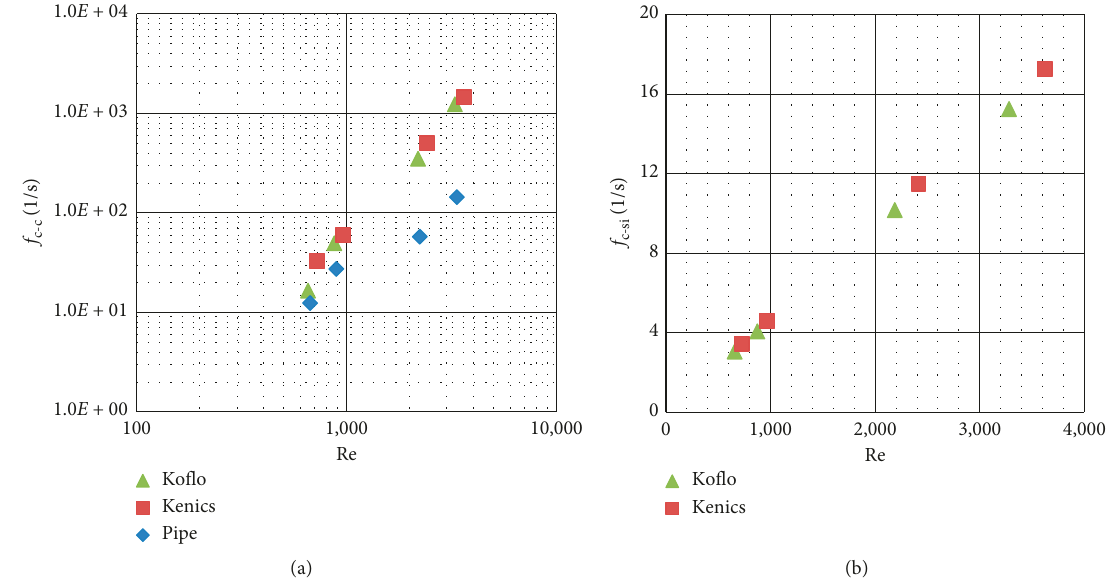
Figure 25: The frequency of interactions: (a) crystal-crystal collisions; (b) crystal-static inserts collisions.